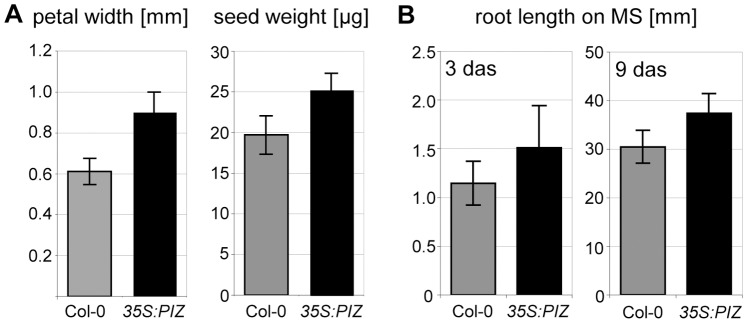
Growth of flowers, seeds and roots is enhanced in 35S:PIZ plants.(A) Petal width and seed weight. Error bars represent ±SD of the means. n ≥ 35 for petal width (p<0.001, student’s t-test) and n = 3 (p<0.05, student’s t-test) for seed weight. (B) Root length of 3-day-old (left) and 9-day-old (right) seedlings, n≥22 (p<0.001, student’s t-test).